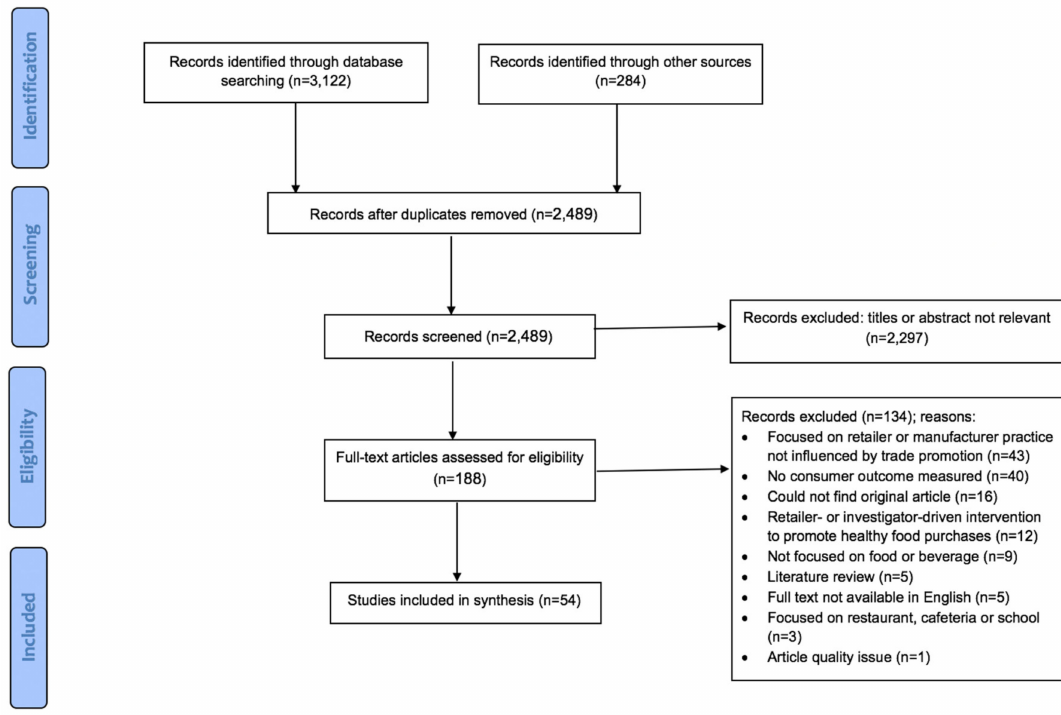
Figure 2. PRISMA Diagram for Research Question